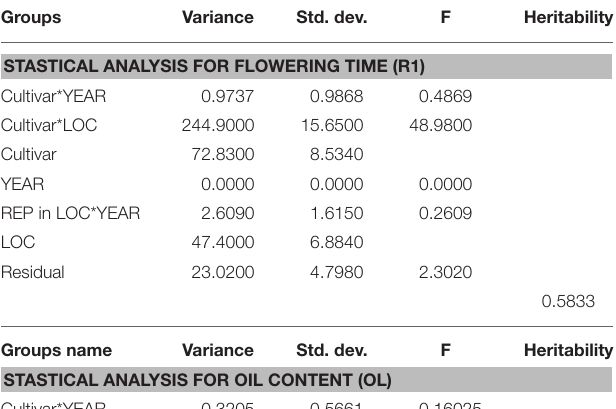
TABLE 3 | The heritability estimates were calculated using variance components obtained by lme4 of R package. Groups